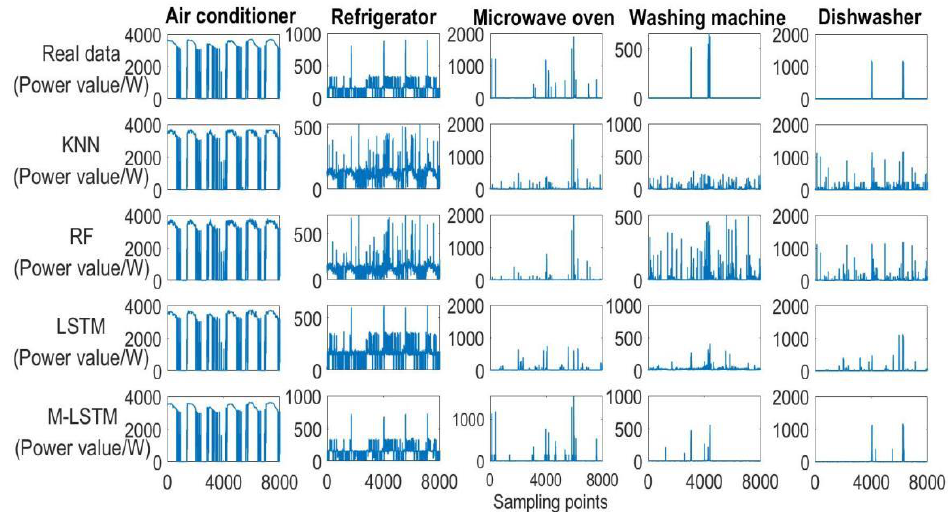
Figure 7. Comparison of WikiEnergy 25 home load decomposition.